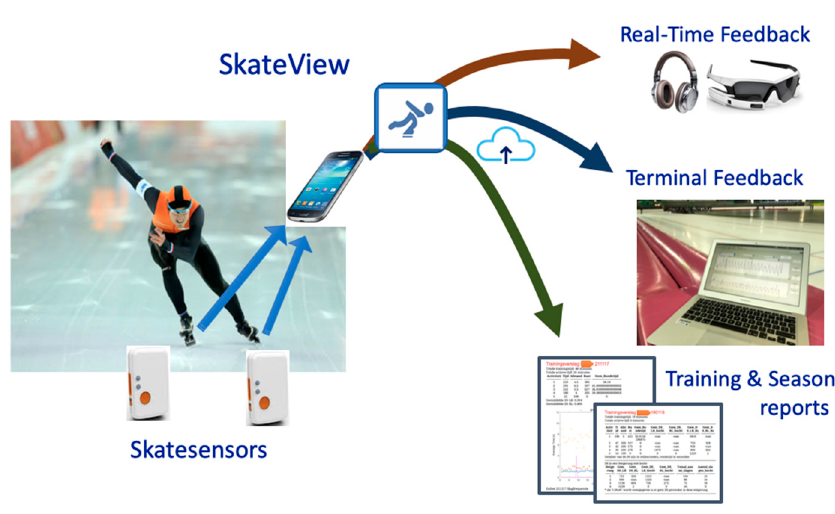
Figure 1. Schematic presentation of the data flow in